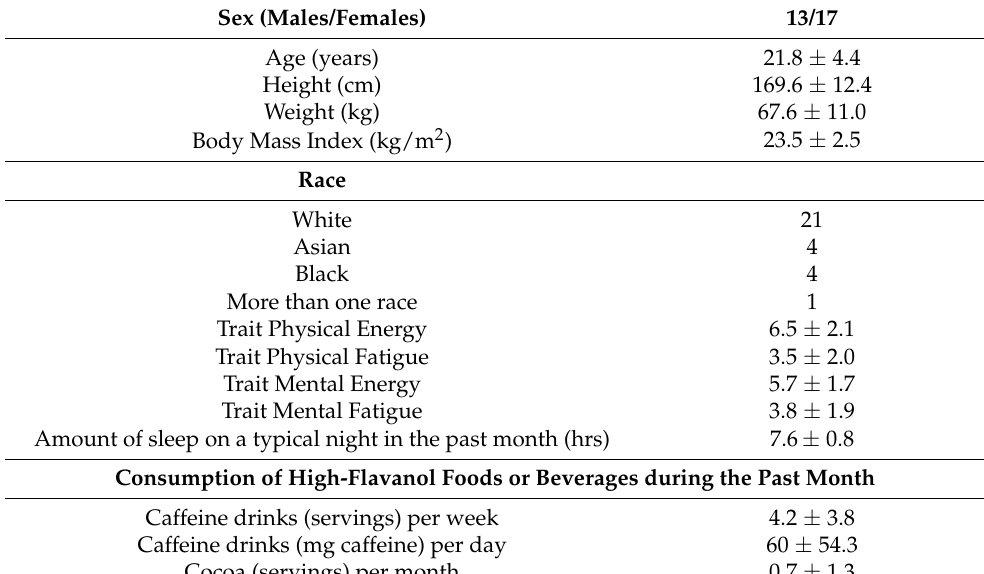
Table 1. Participant